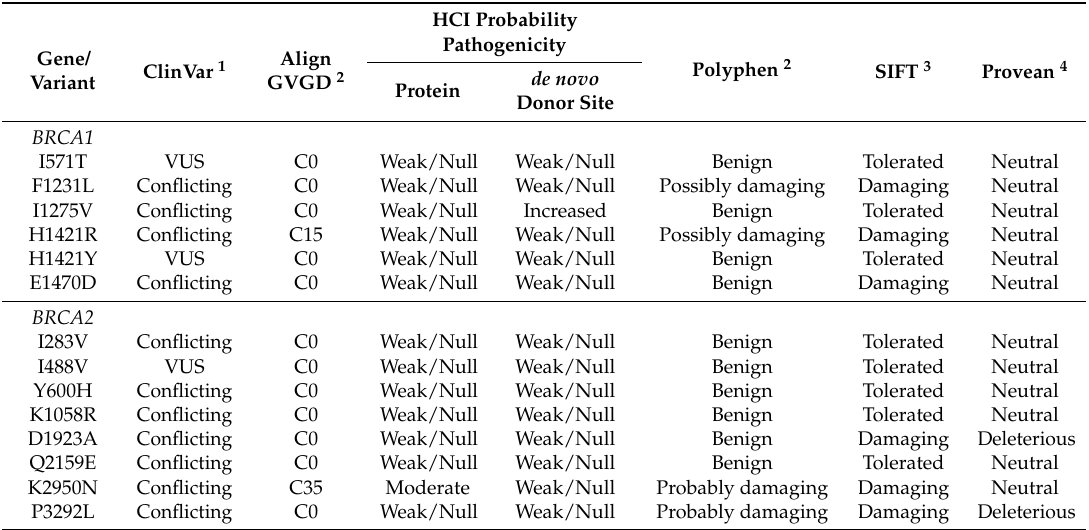
Table 3. In silico predictions of functionality for BRCA1 and BRCA2 missense variants of uncertain significance.